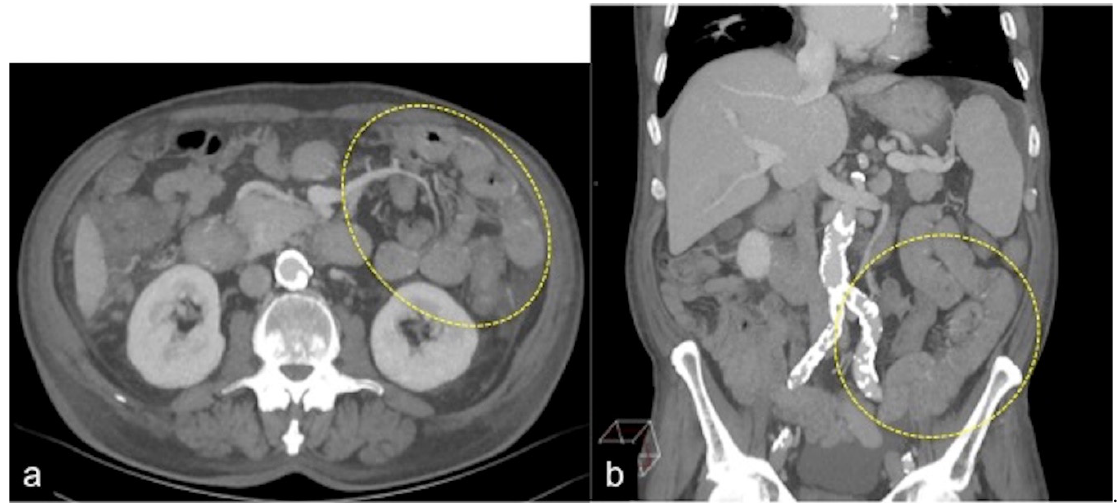
Figure 17. MIP reconstruction of arterial phase ( a ) and angiography study ( b ) of rectal ar- tero-venous malformation. The anatomic detail is very similar when comparing imaging of the two techniques (( a , b ) arrow).